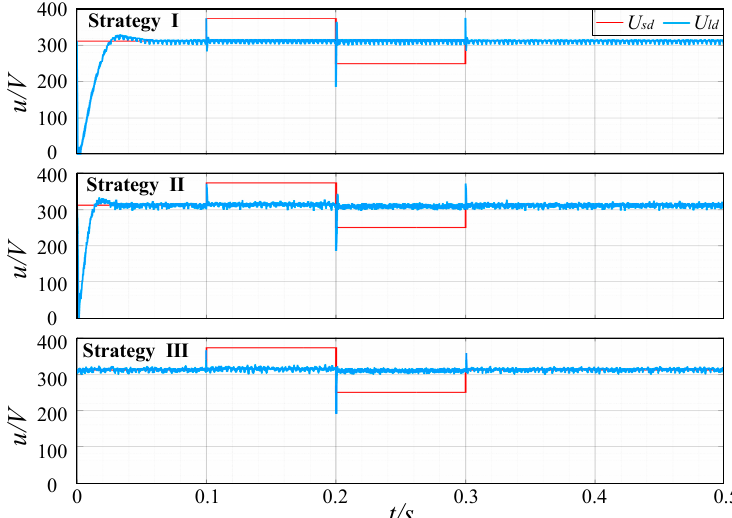
Figure 10. The d-axis DC components of the grid voltage and load voltage.